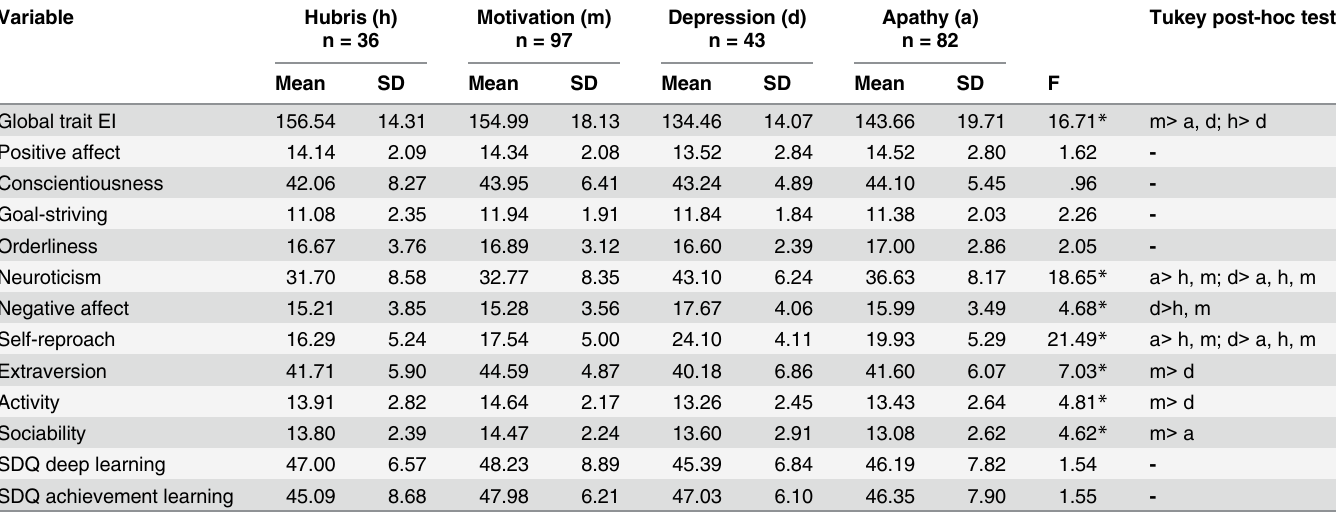
Table 1. Descriptive Statistics and One-Way ANOVA Results for the Appearance